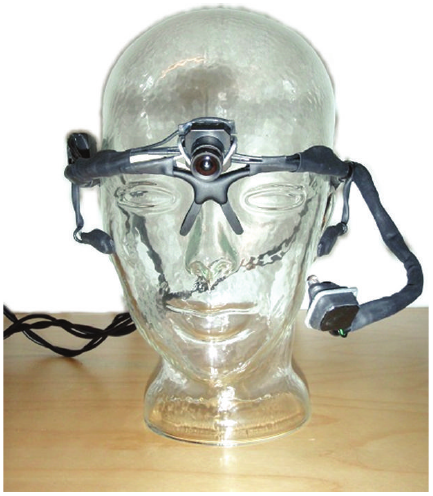
Figure 1: The Face Interface